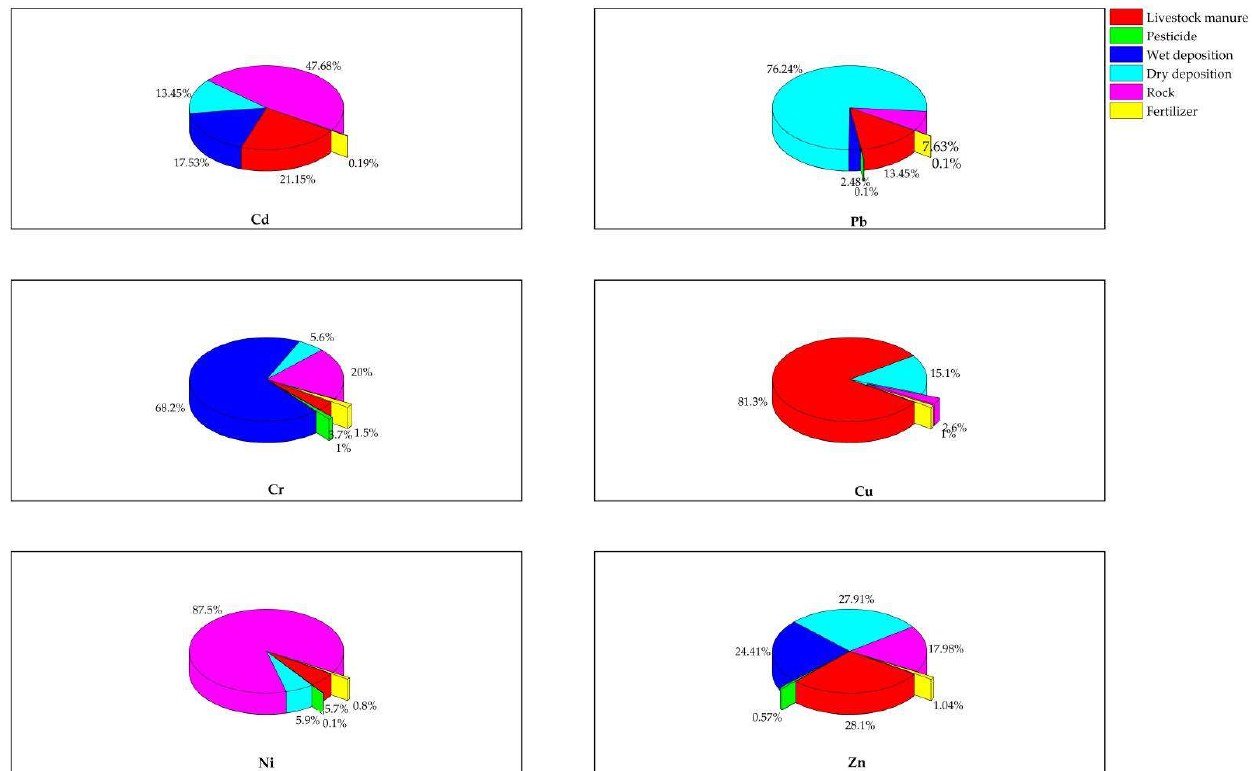
Figure 3. Contributions of pollution sources for Cd, Pb, Cr, Cu, Ni and Zn.